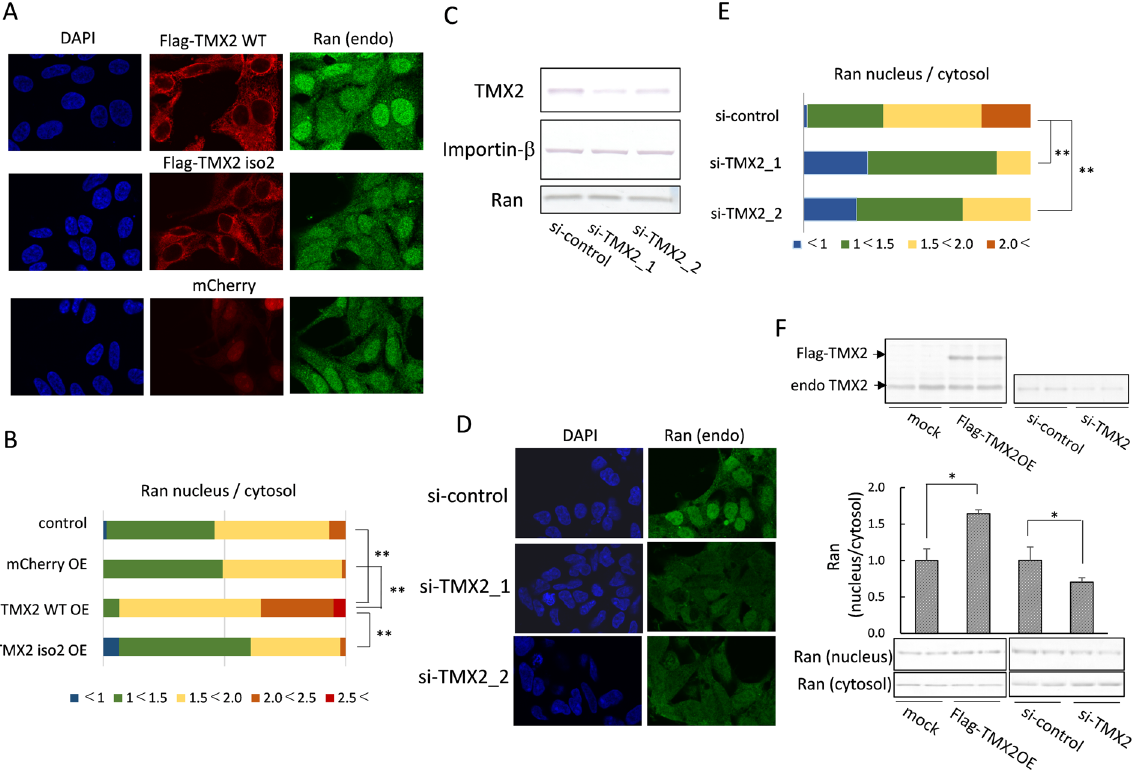
Figure 4. Regulation of the Ran protein gradient by TMX2. ( A ) Flag-TMX2 WT, Flag-isoform 2, or mCherry was overexpressed in HEK293 cells, and the distribution of endogenous Ran was analyzed by immunofluorescence microcopy. ( B ) The ratio of Ran levels in the nucleus/cytosol of each kind of cell (n = 60) was quantified. ( C ) si-RNA targeting for the negative control or TMX2 was lipofected into HEK293 cells, and TMX2, importin- β , or Ran protein levels were analyzed by western blotting. ( D ) Endogenous Ran distribution in TMX2 knockdown cells was analyzed by immunofluorescence microcopy. ( E ) The ratio of Ran levels in the nucleus/cytosol of each kind of cell (n = 60) was quantified. ( F ) The nuclear and cytosolic fractions of TMX2- overexpressing or -knockdown cells were extracted, and analyzed by western blotting with anti-Ran antibody. Values are the means ± S.D. for three experiments. The Ran nucleus/cytosol ratio of control cells (mock or si- control) was set at 1.0. * p < 0.05, ** p <